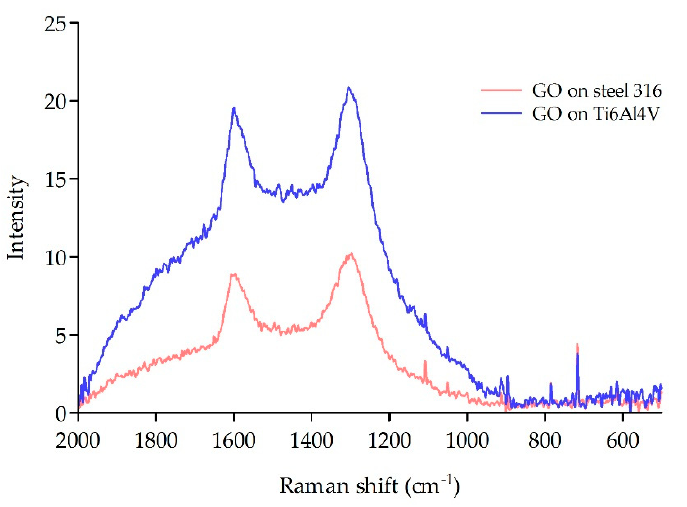
Figure 4. Raman spectrum of screws examined with deposited GO.